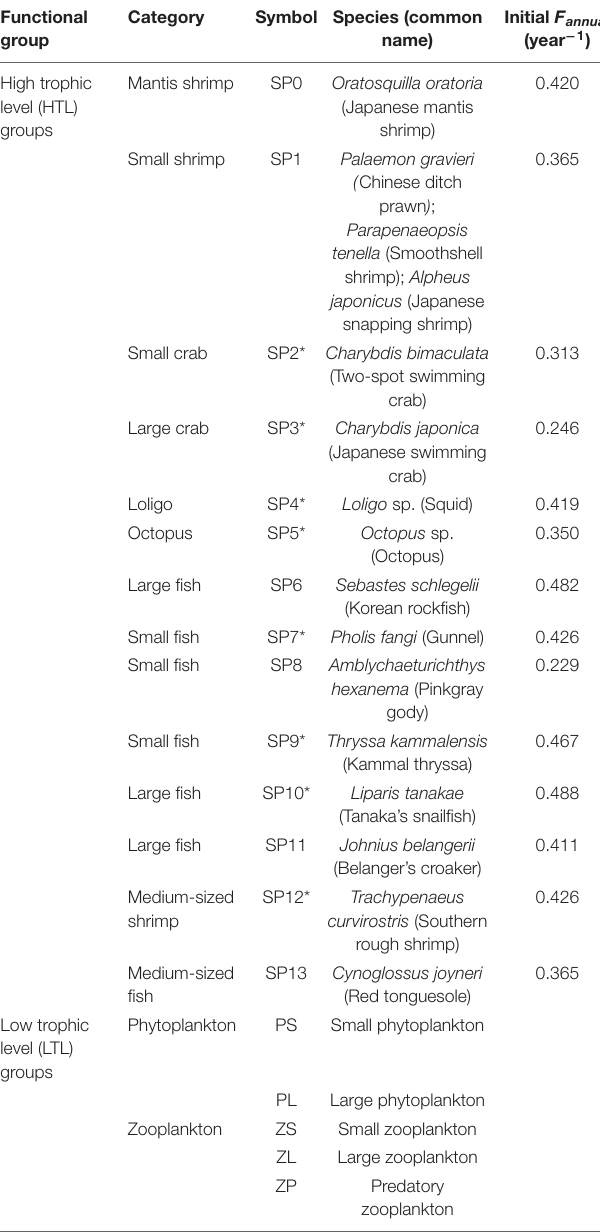
TABLE 1 | High trophic level (HTL) and low trophic level (LTL) groups modeled in the initial OSMOSE-JZB built by Xing et al. (2017). Functional